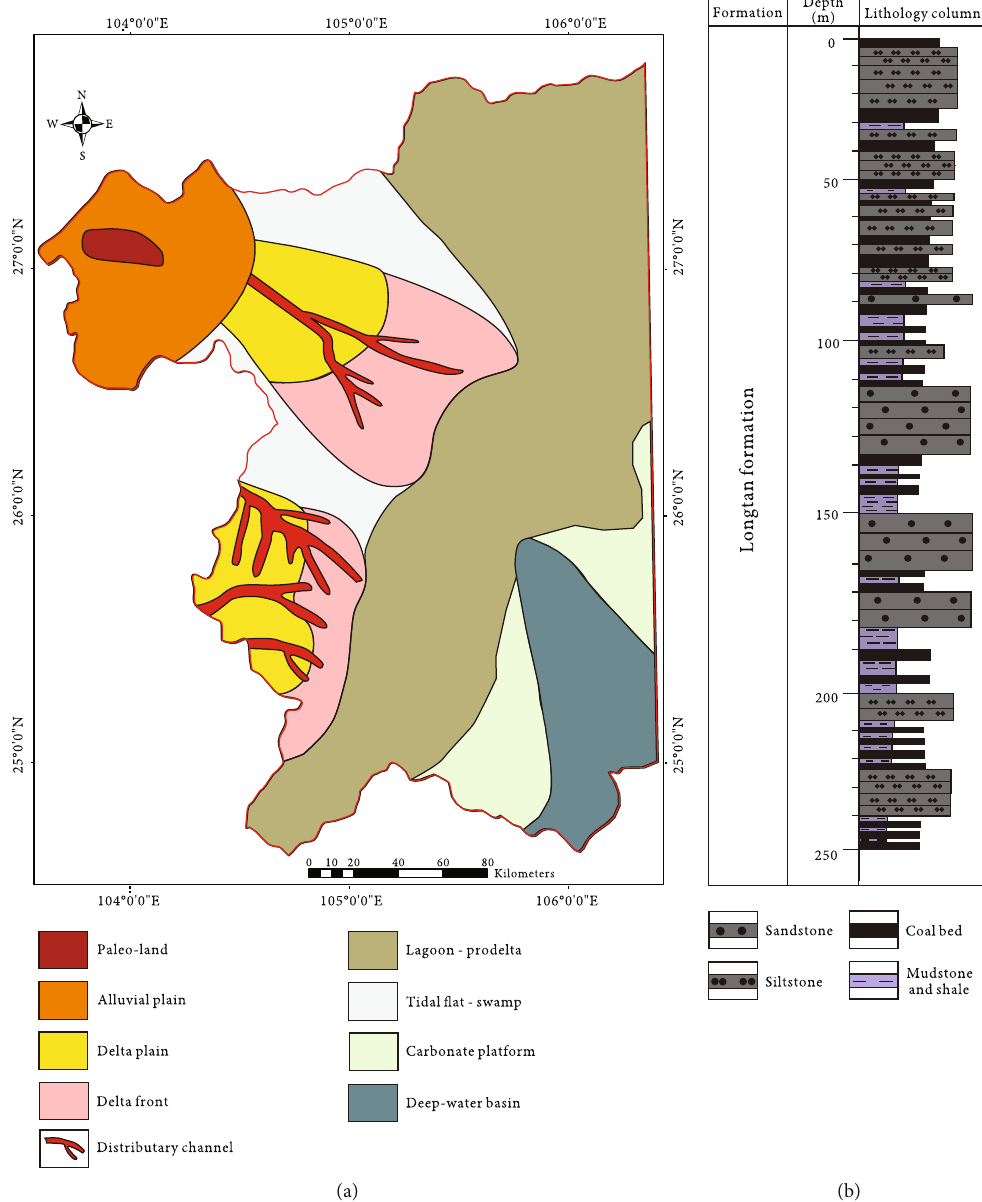
Figure 2: The sedimentary environments (modi fi ed from Shen et al. [38]) and lithology types of the Longtan Formation in west Guizhou: (a) paleogeography map of the Upper Permian Longtan Formation in the study area and (b) typical lithological column of the Longtan Formation in the study